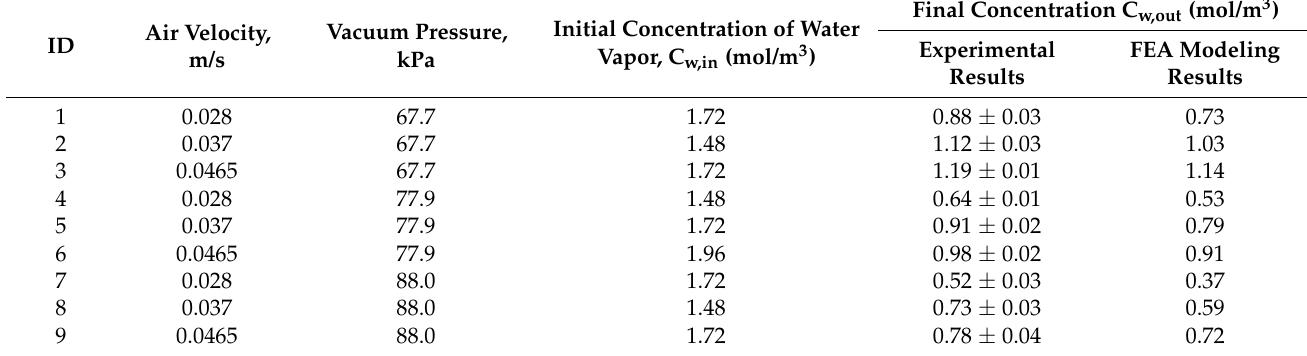
Table 3. Summary of experimental and modeling